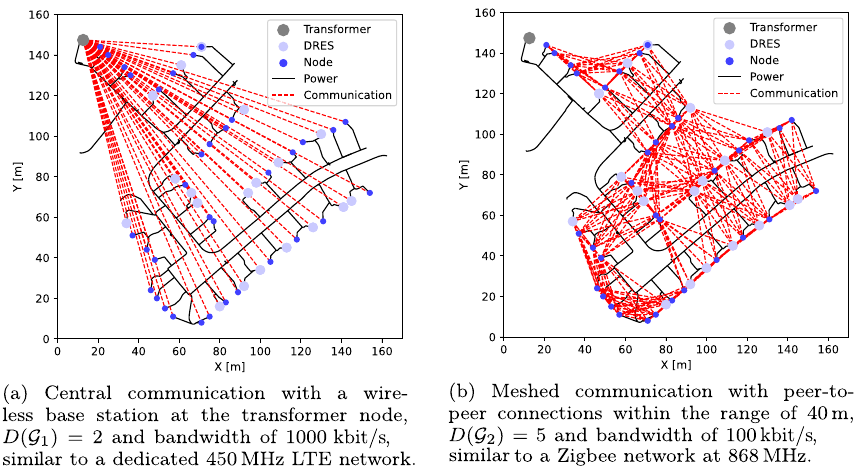
Fig. 4 Communication networks mapped on the IEEE 906 low voltage test